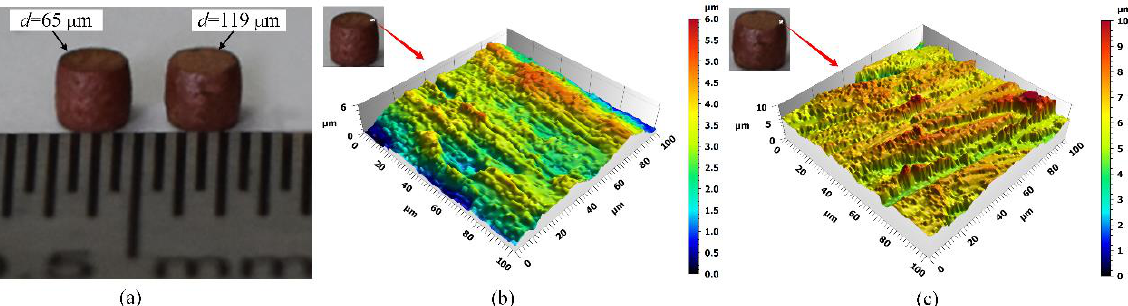
Figure 19. ( a ) Specimens after deformation with different grain sizes; the surface topography of corresponding regions with different grain sizes: ( b ) d = 65 μm, S q = 0.90 μm; and ( c ) d = 119 μm, S q = 1.03 μm.